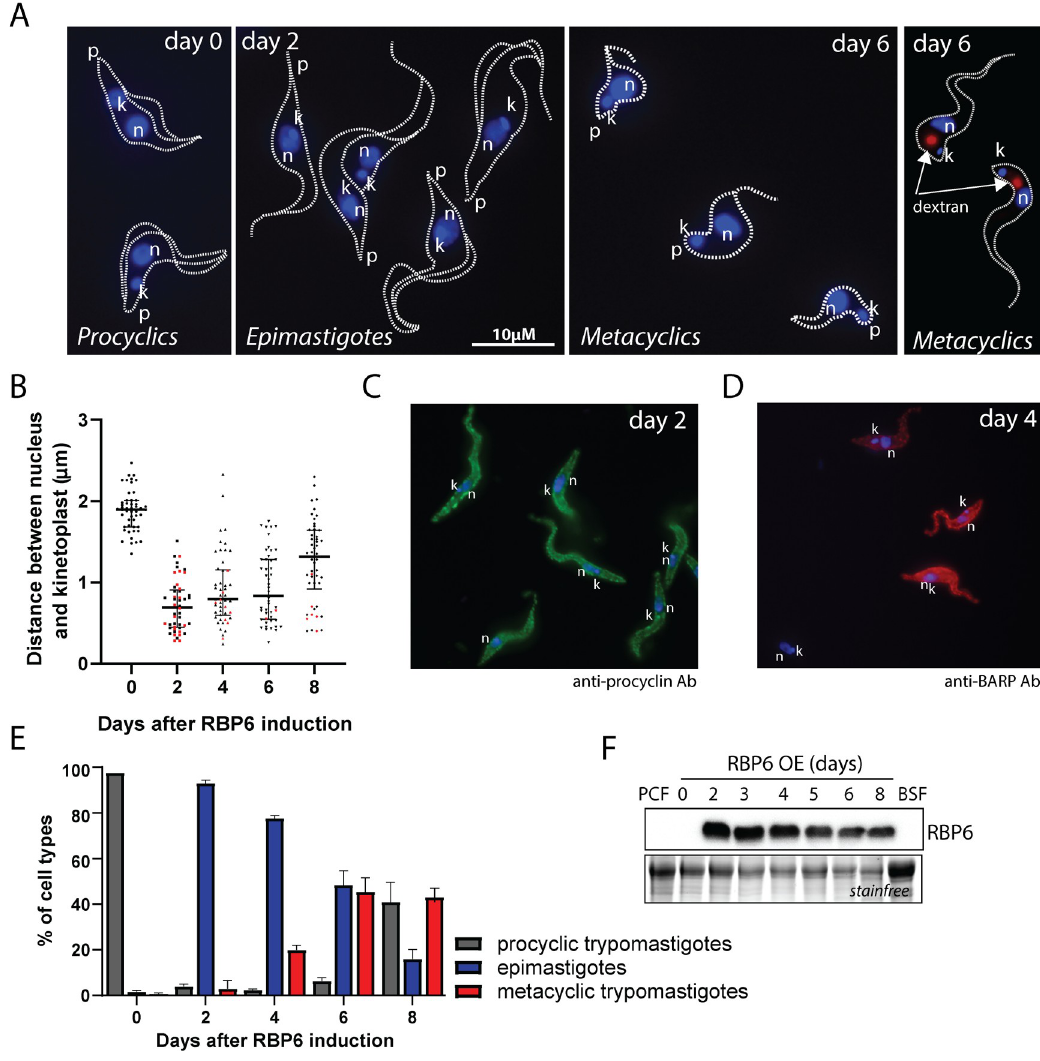
Fig 1. RBP6-induced differentiation of PCF T . brucei cells in the absence of glucose. (A) Imaging of procyclic, epimastigote, and metacyclic forms. Cells were characterized by means of morphological features such as shape, size, and the relative position of the kinetoplast to the nucleus, as well as by internalization of fluorescently labeled dextran. DNA was visualized by DAPI staining. (B) Quantification of the intracelullar distance between kDNA and nucleus. For each day, 50 cells were used for measurements. The red dots indicate cells with anterior localization of their kDNA. (C) Immunofluorescence analysis of RBP6 OE cells at day 2 using anti-procyclin antibody. (D) Immunofluorescence analysis of RBP6 OE cells at day 4 using anti-BARP antibody. (E) Time line for the appearance of epimastigotes and metacyclic cells upon induction of RBP6 OE . (F) Western blot analysis of whole-cell lysates from RBP6 OE cells. Underlying data plotted in panels B and E are provided in S1 Data. Ab, antibody; BARP, brucei alanine-rich protein; BSF, bloodstream form; k, kinetoplast (mitochondrial DNA); kDNA, kinetoplast DNA; n, nucleus; p, posterior end; PCF, procyclic form; RBP6, RNA binding protein 6.